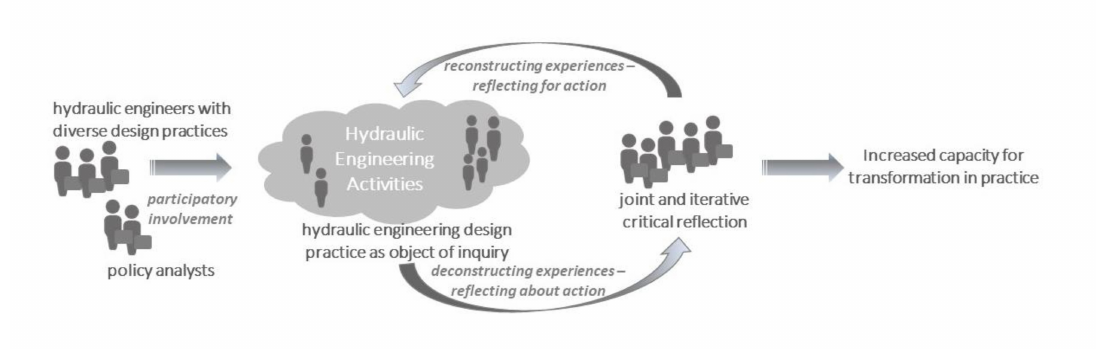
Figure 1. The method of critical reflection employed in this